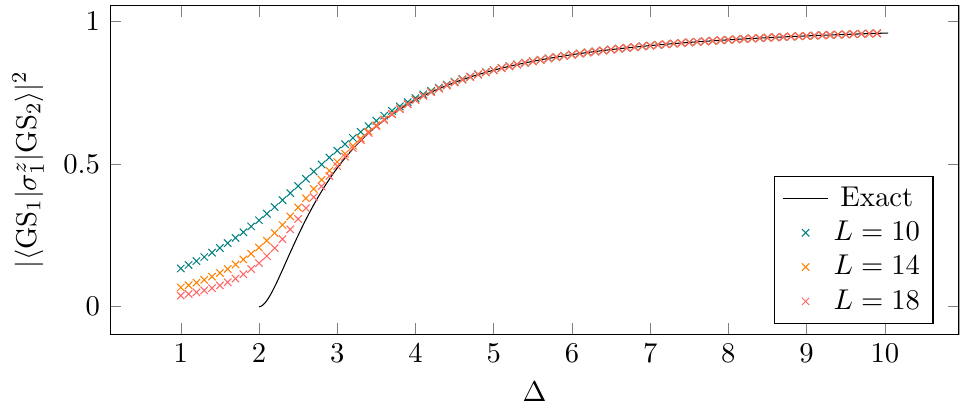
Figure 13: Form Factor between the two degenerate ground states at h − = h + = 1 in the thermodynamic limit with respect to the anisotropy ∆ from equation (5.48) compared to its value at finite size obtained by numerical exact